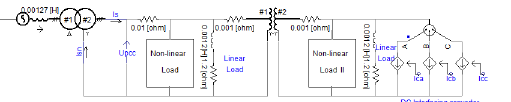
Fig 2. Simplified PSCAD simulation model of the DG system depicted in Fig